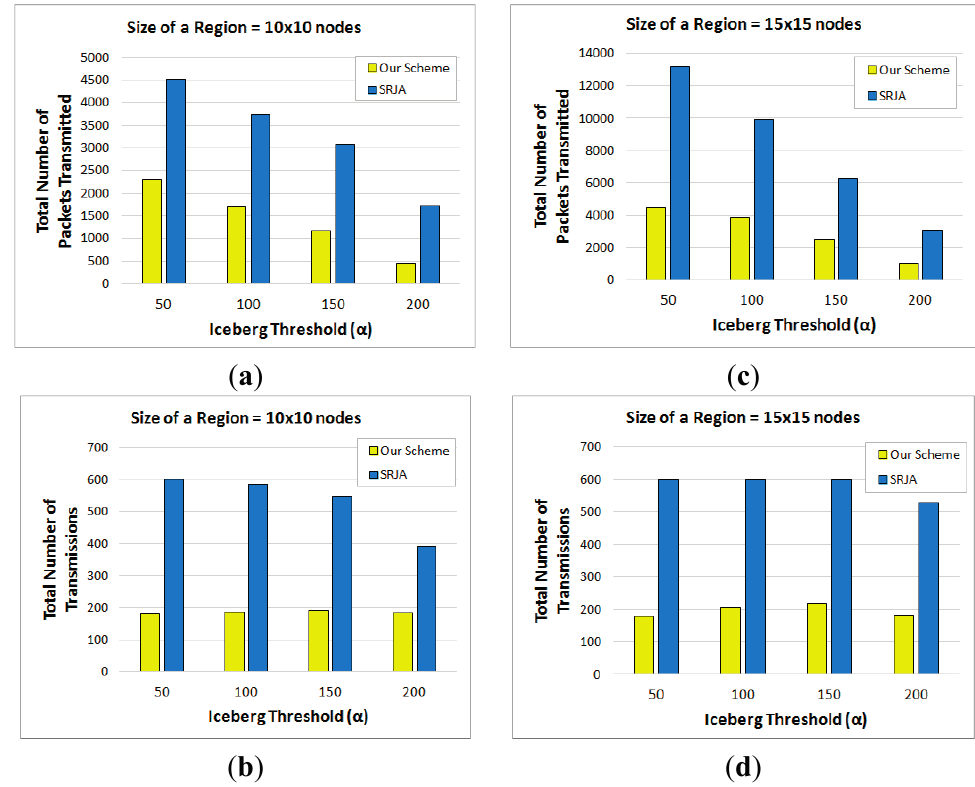
Figure 12. Performance Comparison with respect to Varying Iceberg Thresholds. ( a ) Total number of packets transmitted (10 × 10 nodes); ( b ) Total number of transmissions (10 × 10 nodes); ( c ) Total number of packets transmitted (15 × 15 nodes); ( d ) Total number of transmissions (15 × 15